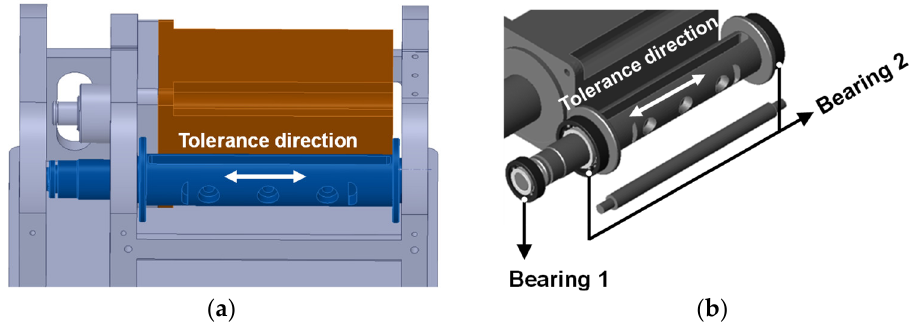
Figure 7. Design variable–Assembly tolerance: ( a ) Case 1: Main shaft; ( b ) Case 2: Bearing.